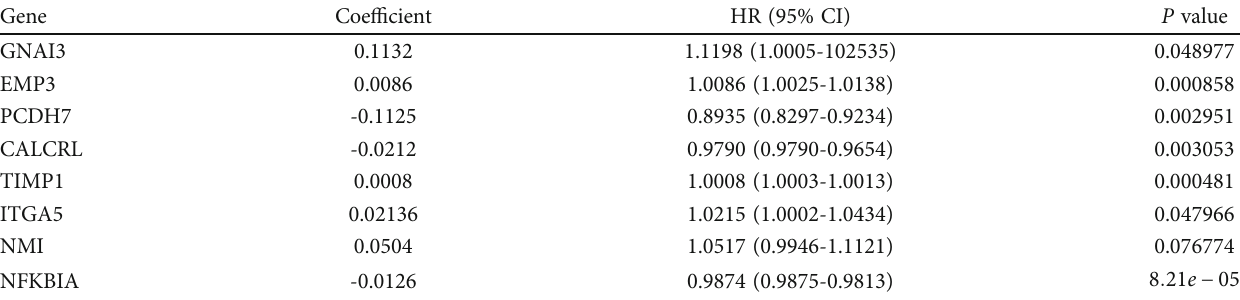
Table 2: Coe ffi cients of the eight target IRRGs from the multivariate Cox regression